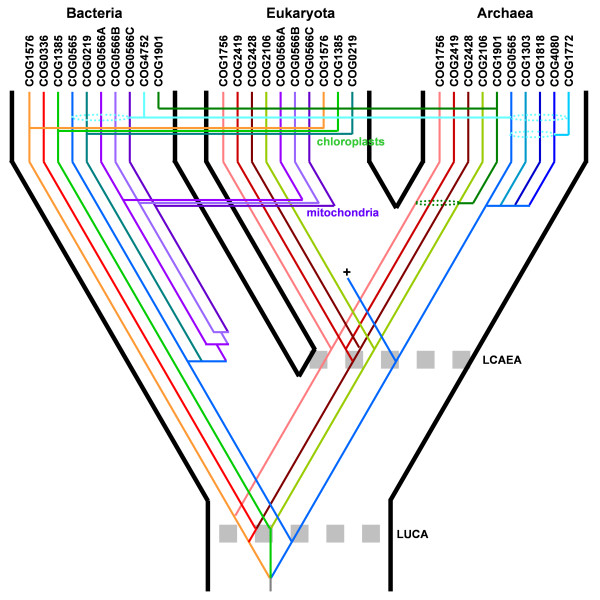
A speculative scenario of the evolutionary history of the SPOUT superfamily. This scenario is based on the assumption that Bacteria, Archaea, and Eukaryota are all monophyletic, that Archaea and Eukaryota are sister lineages, and that the root (corresponding to the LUCA) is located in the branch between Bacteria and the Last Common Ancestor of Eukaryota and Archaea (LCAEA). Three major branches corresponding to the three Domains of Life. Lines in different colors indicate COGs (blue: 2'-O-ribose methylation, red: m1G methylation, green: m3U methylation, grey – unknown). Crosses indicate extinction. Dotted arrows indicate putative horizontal gene transfers. Dashed ellipses indicate uncertainty in the assignment of genes that underwent duplication to yield a particular COG, e.g. they encompass sets of potential mother lineages.